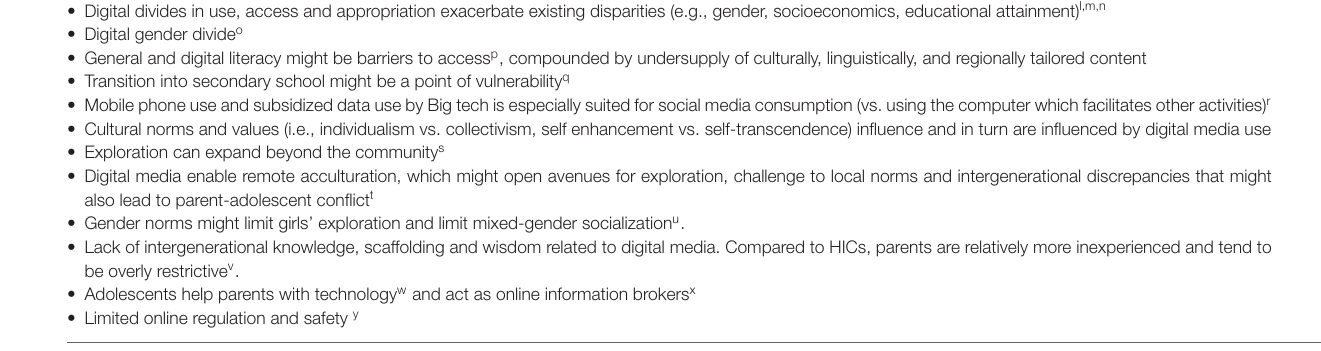
TABLE 2B | LMICs considerations that apply broadly to digital media use in